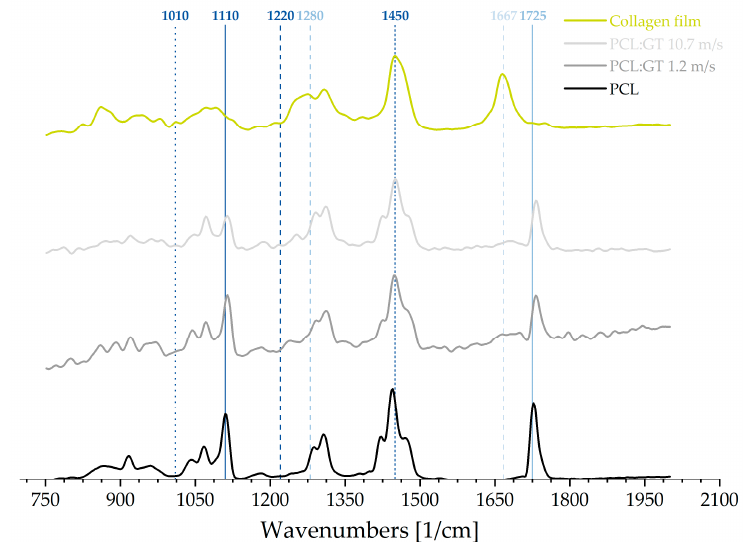
Figure 2. Raman spectra of pure PCL, PCL:GT 1.2 m / s, PCL:GT 10.7 m / s and collagen film. PCL is displayed in black, PCL:GT 1.2 m / s in dark grey, PCL:GT 10.7 m / s in light grey and collagen film in green. The vertical lines represent characteristic wavenumbers: phenylalanine (1010 cm –1 ; dotted dark blue), PCL (1110 cm –1 ; solid dark blue and 1725 cm –1 ; solid blue), amide (II: 1220 cm –1 ; dashed dark blue, III: 1280 cm –1 ; dashed blue and I: 1667 cm –1 ; dashed light blue) and lysine (1450 cm –1 ; small dashed dark blue), with the solid lines marking the PCL-typical bands and the dashed and dotted lines marking the protein typical bands.